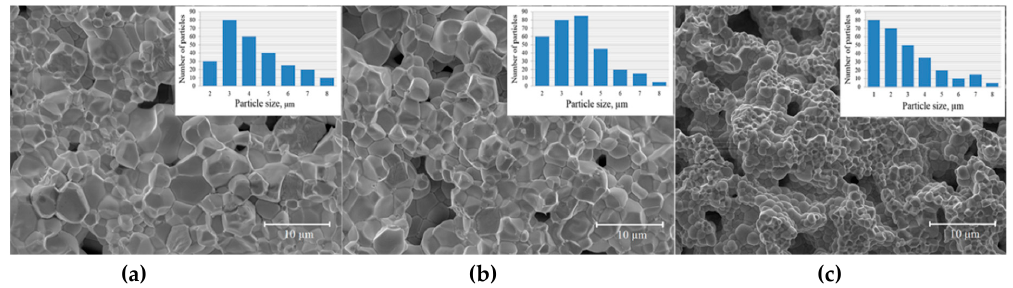
Figure 3. SEM images of the compounds Bi 1 − x Ba x Fe 1 − x Ti x O 3 with x = 0.27 ( a ), 0.3 ( b ), and 0.35 ( c ) (left to right). The insets show the distribution of crystal grain size.